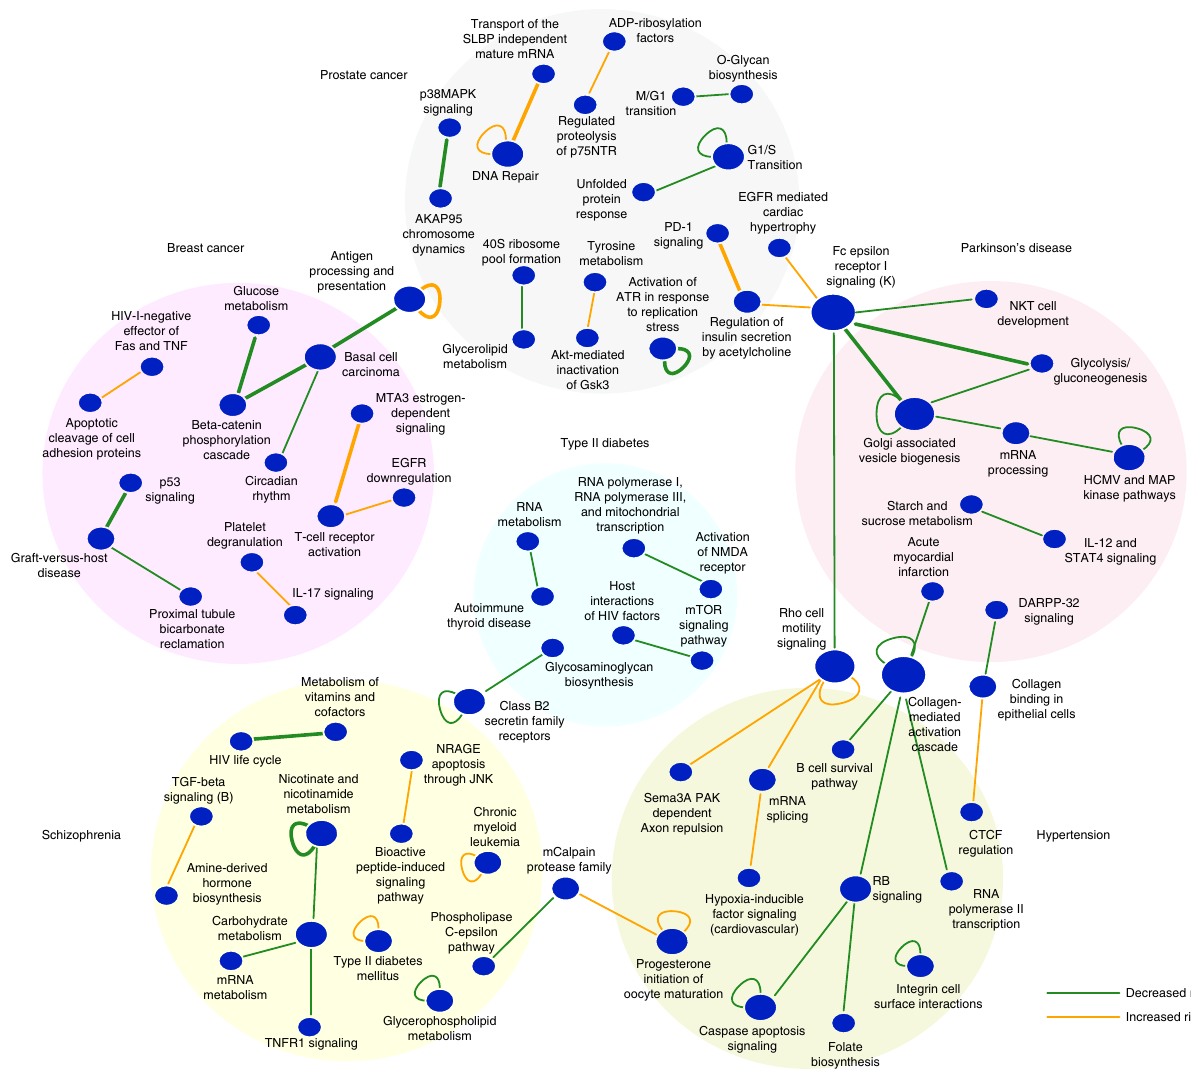
Fig. 5 Between-pathway and within-pathway interactions discovered from six different diseases. Network representation of a set of signi fi cant between- pathway (BPM) or within-pathway (WPM) interactions (FDR ≤ 0.25) that are associated with increased (orange edges) and decreased (green edges) risk of corresponding diseases. Replicated interactions are shown as bold lines. Discoveries from different diseases are indicated by different background colors. Only the most signi fi cant 10 BPM/WPMs are shown for each GWAS cohort (see Supplementary Data 4, 9 – 18 for complete